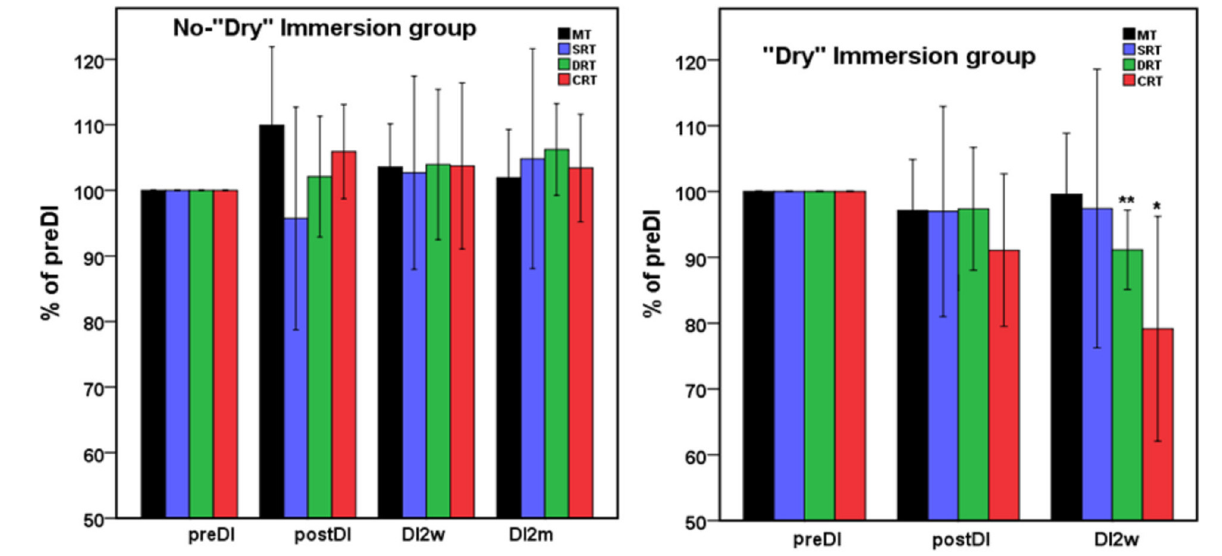
FIGURE 1 | Mean percent of the studied RT tasks across the program of DI with respect to the background data (point preDI) in the control group (left) and in the study group (with DI) (right). The point “DI2m” is not presented for the DI group (right) as data on four subjects were missing. MT, motor time; SRT, simple reaction time; DRT, disjunctive reaction time; CRT, choice reaction time. Data are mean ± SD, * p < 0.05 vs. preDI, ** p < 0.01 vs.